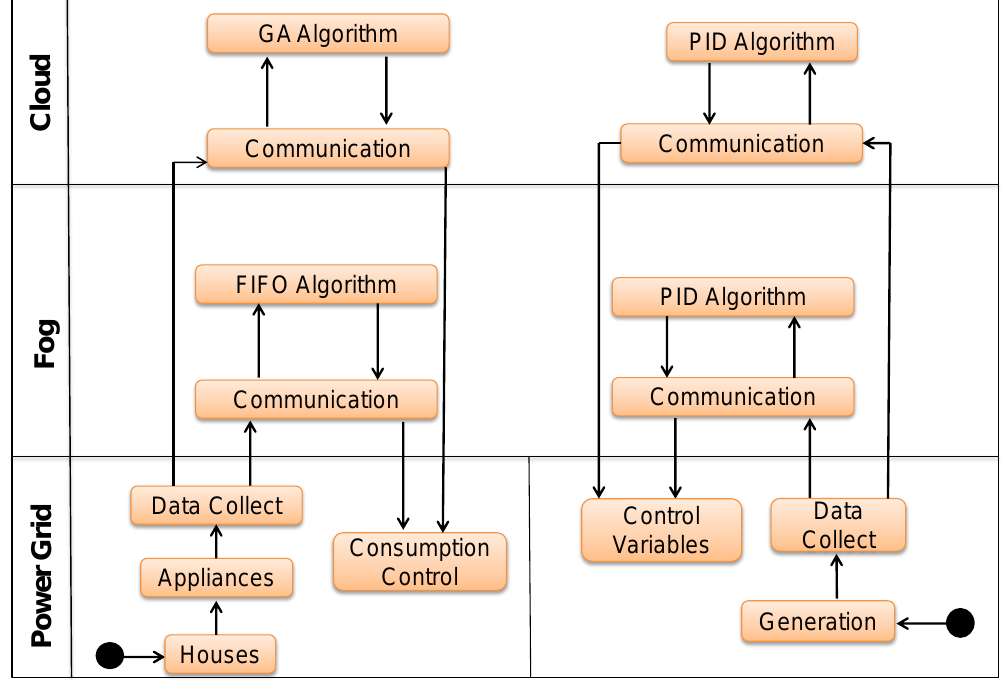
Figure 2. Power generation managed by the PID controller and GA and FIFO algorithm in the